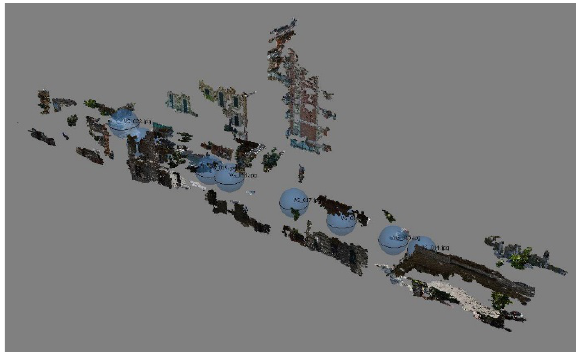
Figure 5: Alignment of the spherical images from Google Street View and dense cloud processing.